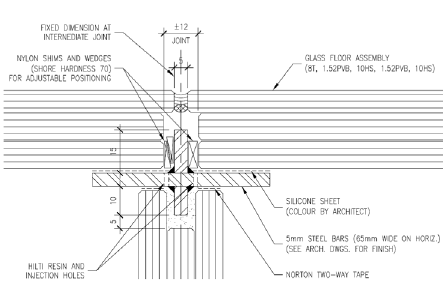
Figure 1: Balustrade splice connection (initial concept).